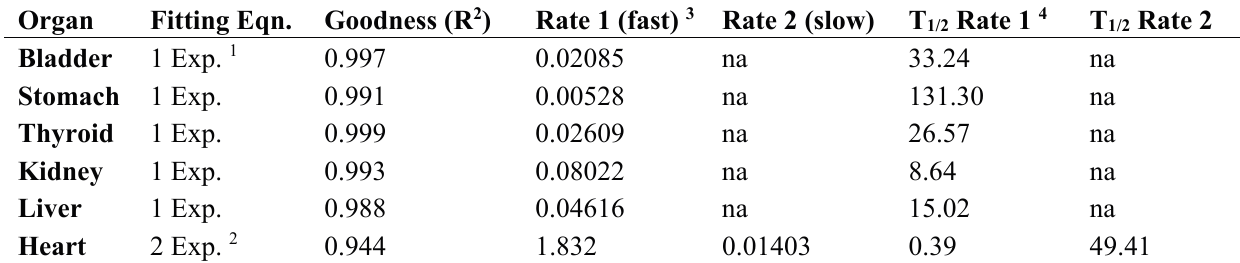
Table 2. Pharmacokinetic rate constants for 124 I-p5+14 in amyloid free, wild type mice. Organ Fitting